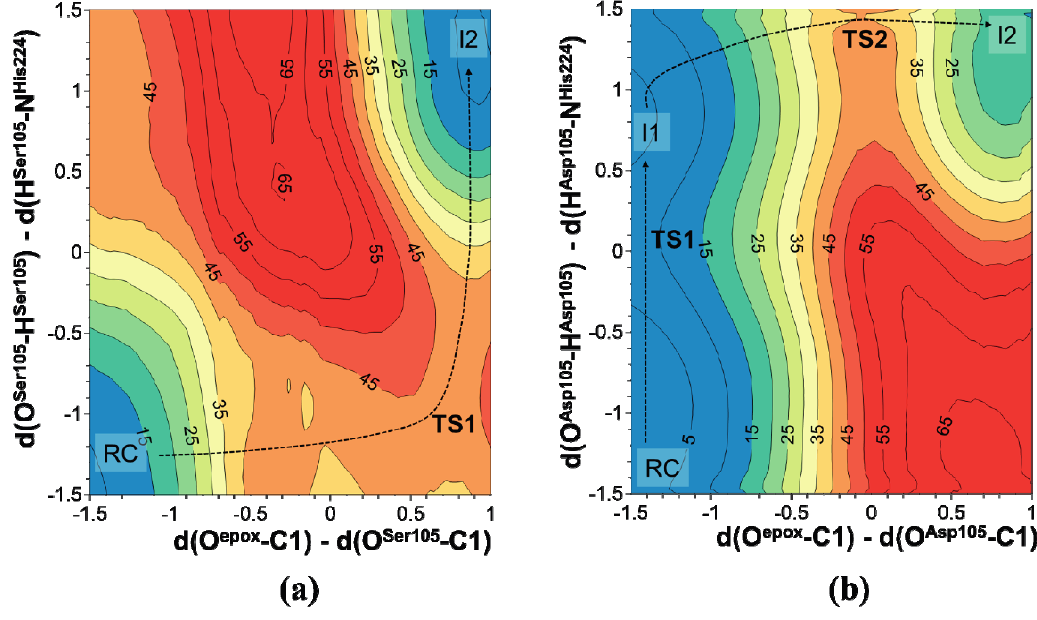
Figure 4. PES of the nucleophilic attack to C1 carbon atom of t-DPPO(1) by ( a ) Ser105 in wild-type CALB and ( b ) Asp105 in Ser105Asp